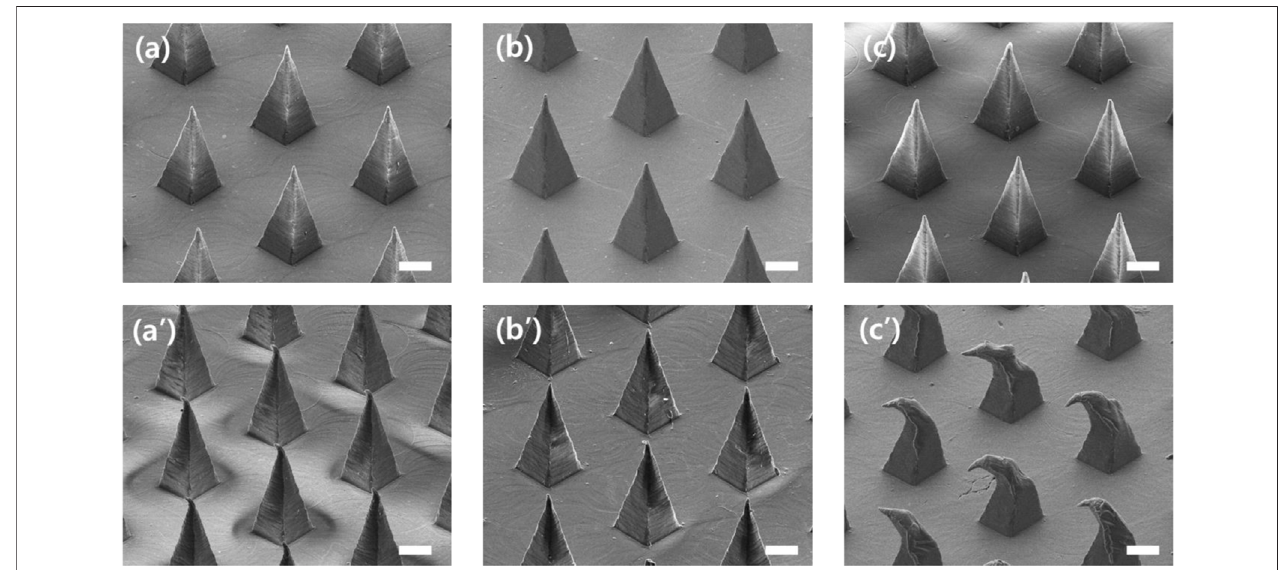
FIGURE 6 | SEM image of microneedles before and after swabbing with swab S-N3-I3-S7 (A,B) Before and after swabbing with polylactic acid (PLA) MN (C,D) Before and after swabbing with cyclic ole fi n copolymer (COC) MN. (E,F) Before and after swabbing with polycaprolactone (PCL) MN (scale bars, 100 μ m).